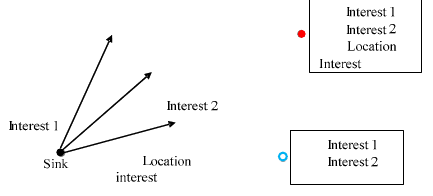
Figure 5. The broadcast flooding mechanism in network.